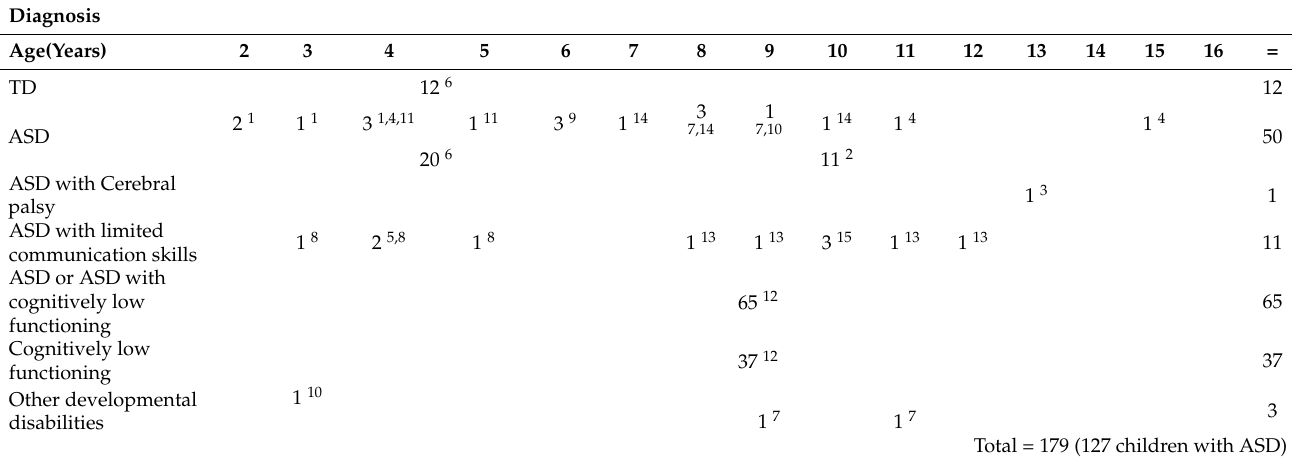
Table 1. Participants’